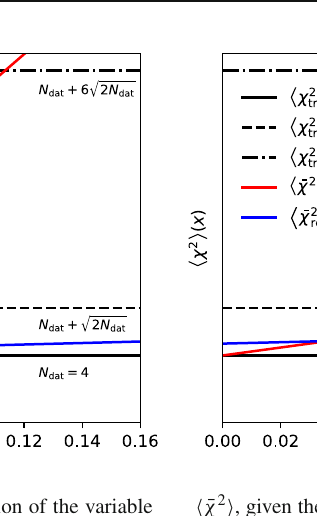
Fig. 1 The expectation value of the χ 2 , as a function of the variable x , in the toy model, for two values of the parameter (cid:7) : (cid:7) = 0 . 1 (left) and (cid:7) = 0 . 25 (right). We show: the true expectation value of Eq. (30), (cid:5) χ 2 (cid:6) (with one and six standard deviations for reference), given the true matrix of uncertainties A , Eq. (27); the expectation value of Eq. (29),